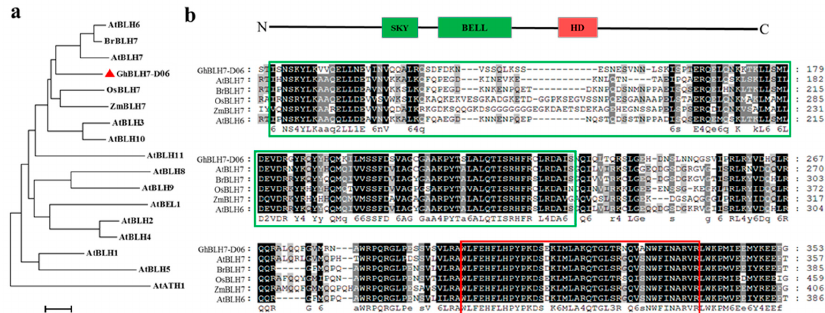
Figure 1. Phylogenetic analysis and sequence alignment of GhBLH7-D06 protein: ( a ) phylogenetic analysis of GhBLH7-D06 with its homologous proteins; and ( b ) multiple sequence analysis of GhBLH7-D06 with its homologous proteins AtBLH7 (AT2G16400.1), AtBLH6 (AT4G34610.1), OsBLH7 (LOC_Os12g43950.1), ZmBLH7 (GRMZM2G004641_P03), and BrBLH7 (Brara.K00337.1.p). The POX (SKY + BELL) domain sequence is in the green boxes, and the Homeobox KN domain (HD) is in the red box.